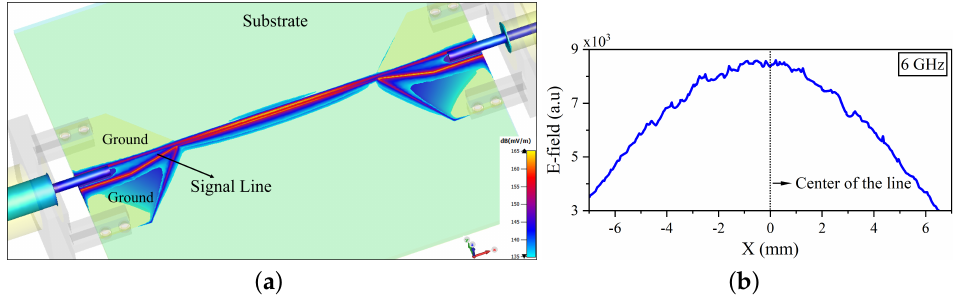
Figure 2. Simulated 3D electric field map. ( a ) The electric field map of the slot line at 6GHz. ( b ) The e-field profile taken along the length of the signal line.